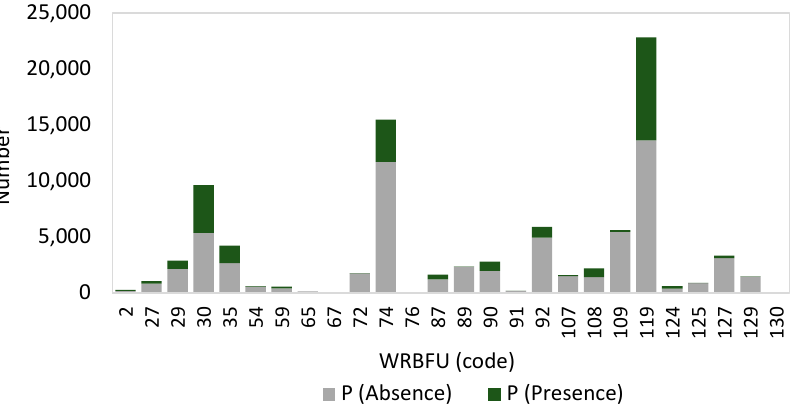
Figure 4. Soil data ( n = 88,455)—occurrence and distribution of the WRFBU codes